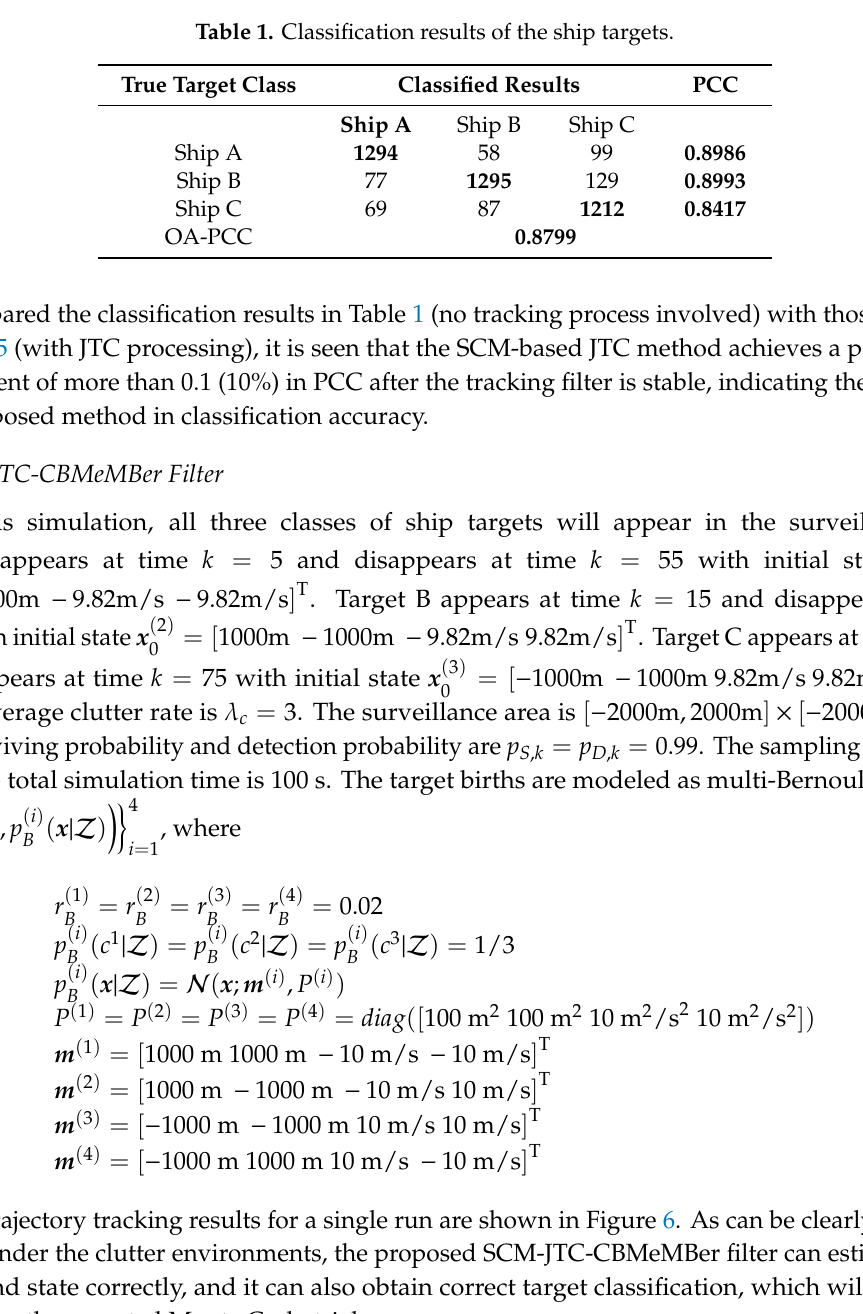
Table 1. The corresponding probabilities of correct classification (PCC) for Target Classes A, B and C are 0.8986, 0.8993 and 0.8417, respectively. The over-all PCC (OA-PCC) for all the test samples is 0.8799. The metric index PCC and OA-PCC are defined as